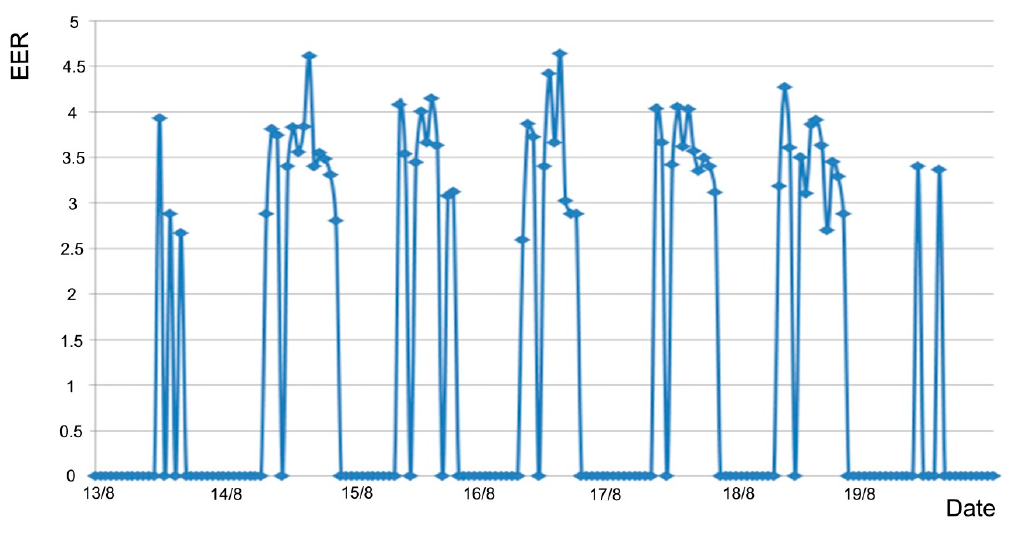
Figure 6. Calculated EER.